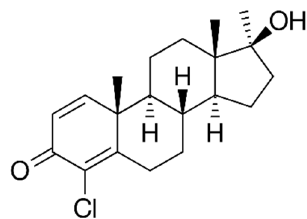
Figure 11. Chemical structure of DHCMT. Formula: C 20 H 27 ClO 2.